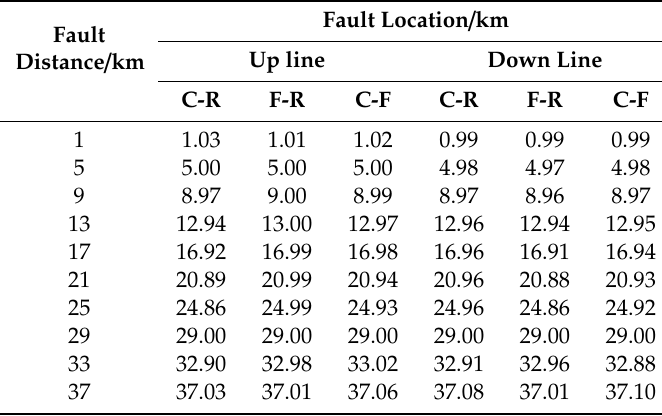
Table 2. Results at di ff erent